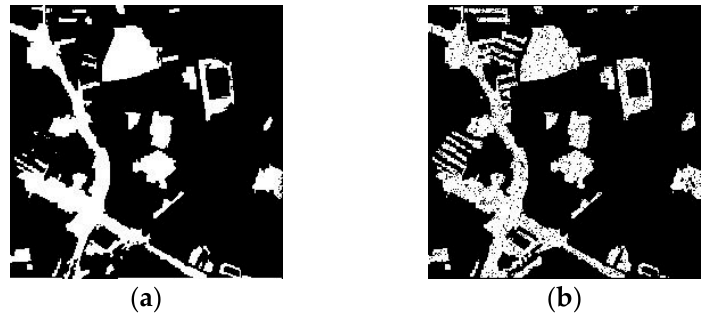
Figure 14. Change detection maps resulting from ( a ) the proposed multi-scale k -means method and ( b ) the method using varying geometric and radiometric properties [35], with L2 as the basis image in the second study area (scale = 50).